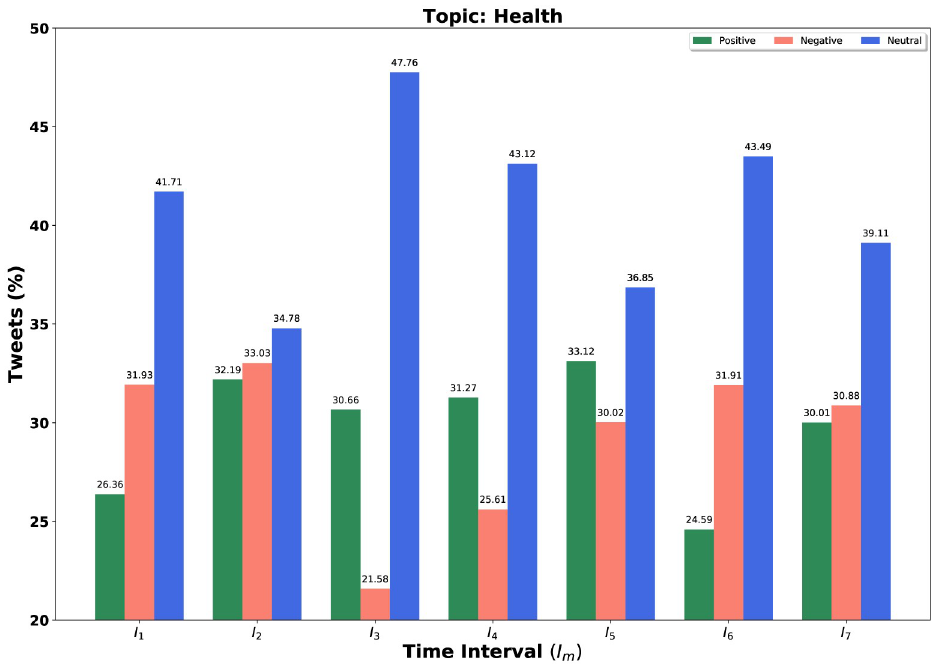
Fig 5. Overall sentiment dynamics on Twitter at different time intervals I